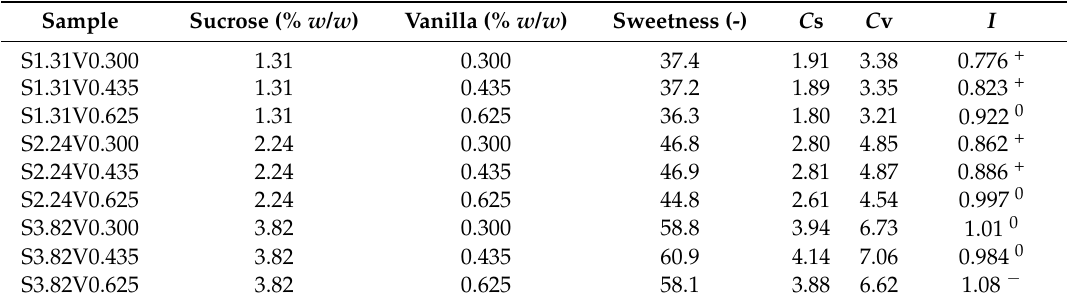
Table 1. Indices of interaction ( I ) for perceived sweetness in the nine sucrose-vanilla mixtures. S = sugar, V = vanilla, C s and C v represent the concentration of sugar and vanilla, respectively, that would individually produce the same intensity as the vanilla-milk mixture. C S and C V were calculated using the dose-response functions for sweetness with the sucrose-only mixtures (Sweetness SW sugar = 17.35 + 10.52 · S; R 2 = 0.43, F(1, 538) = 406.24, p < 0.05) and the vanilla-only mixtures